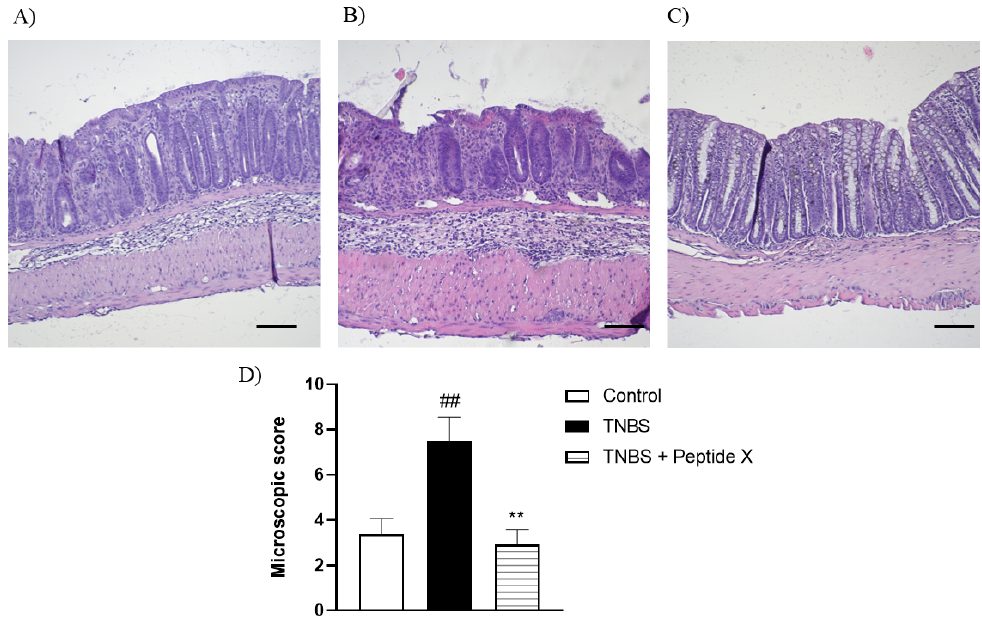
Figure 3. Microscopic total damage score ( D ) and representative micrographs of hematoxylin and eosin-stained sections of the distal colon from ( A ) control, ( B ) TNBS, ( C ) TNBS + peptide X . Scale bar = 100 μ m. ## p < 0.01, as compared to control mice, ** p < 0.01, vs. TNBS-treated animals. Data represent the mean ± SEM of 7–9 mice per group.